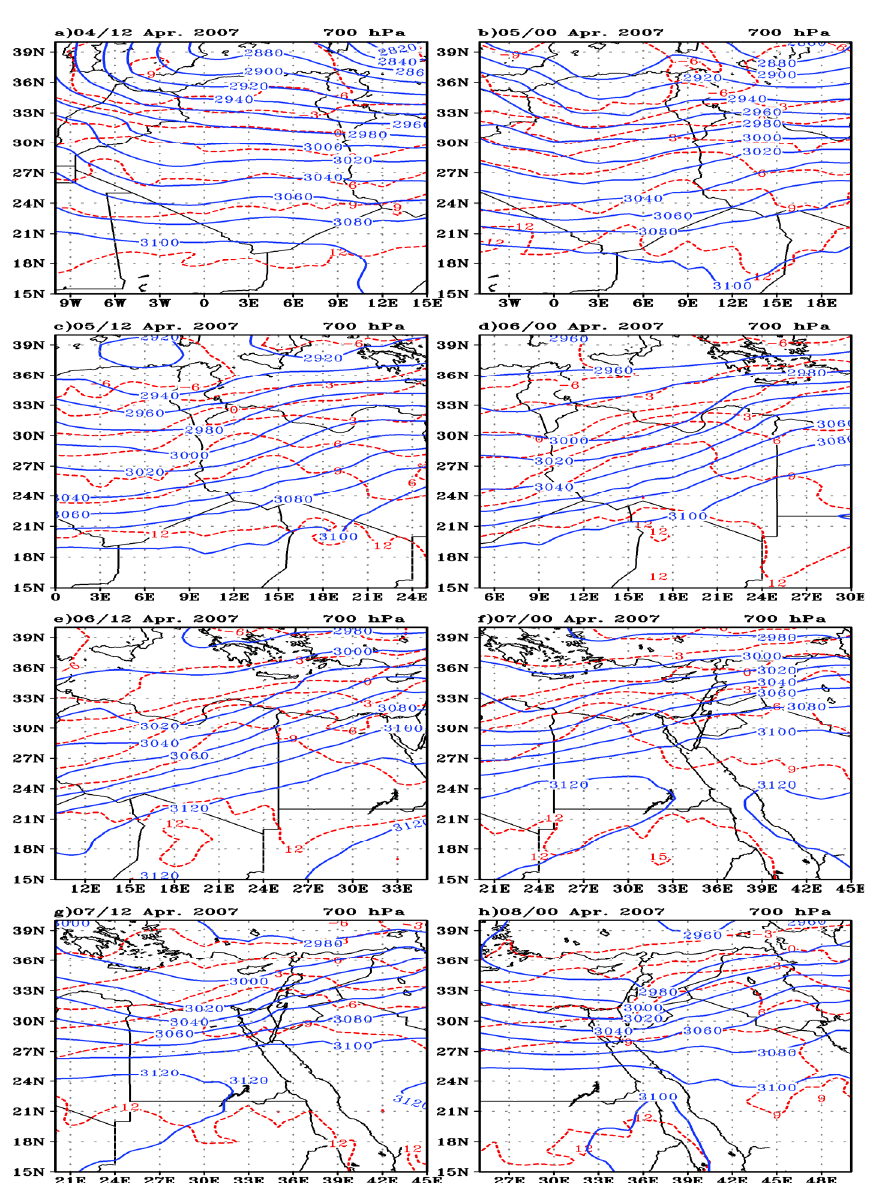
Figure 4. The 700 hPa geopotential height contour at every 20 gpm interval (blue solid) and isotherms (red dashed) every 3 °C at 12Z and 00Z for 4–8 April 2007.